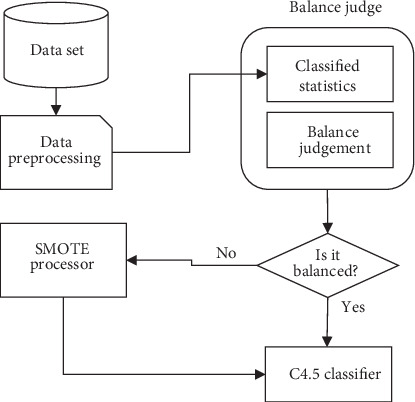
SMOTE+C4.5 classification model.